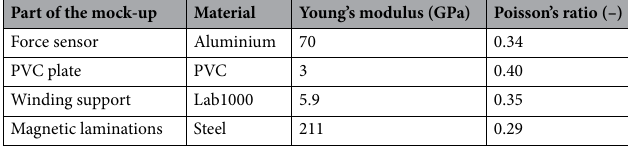
Table 2. Mechanical properties used for mechanical FE simulations.